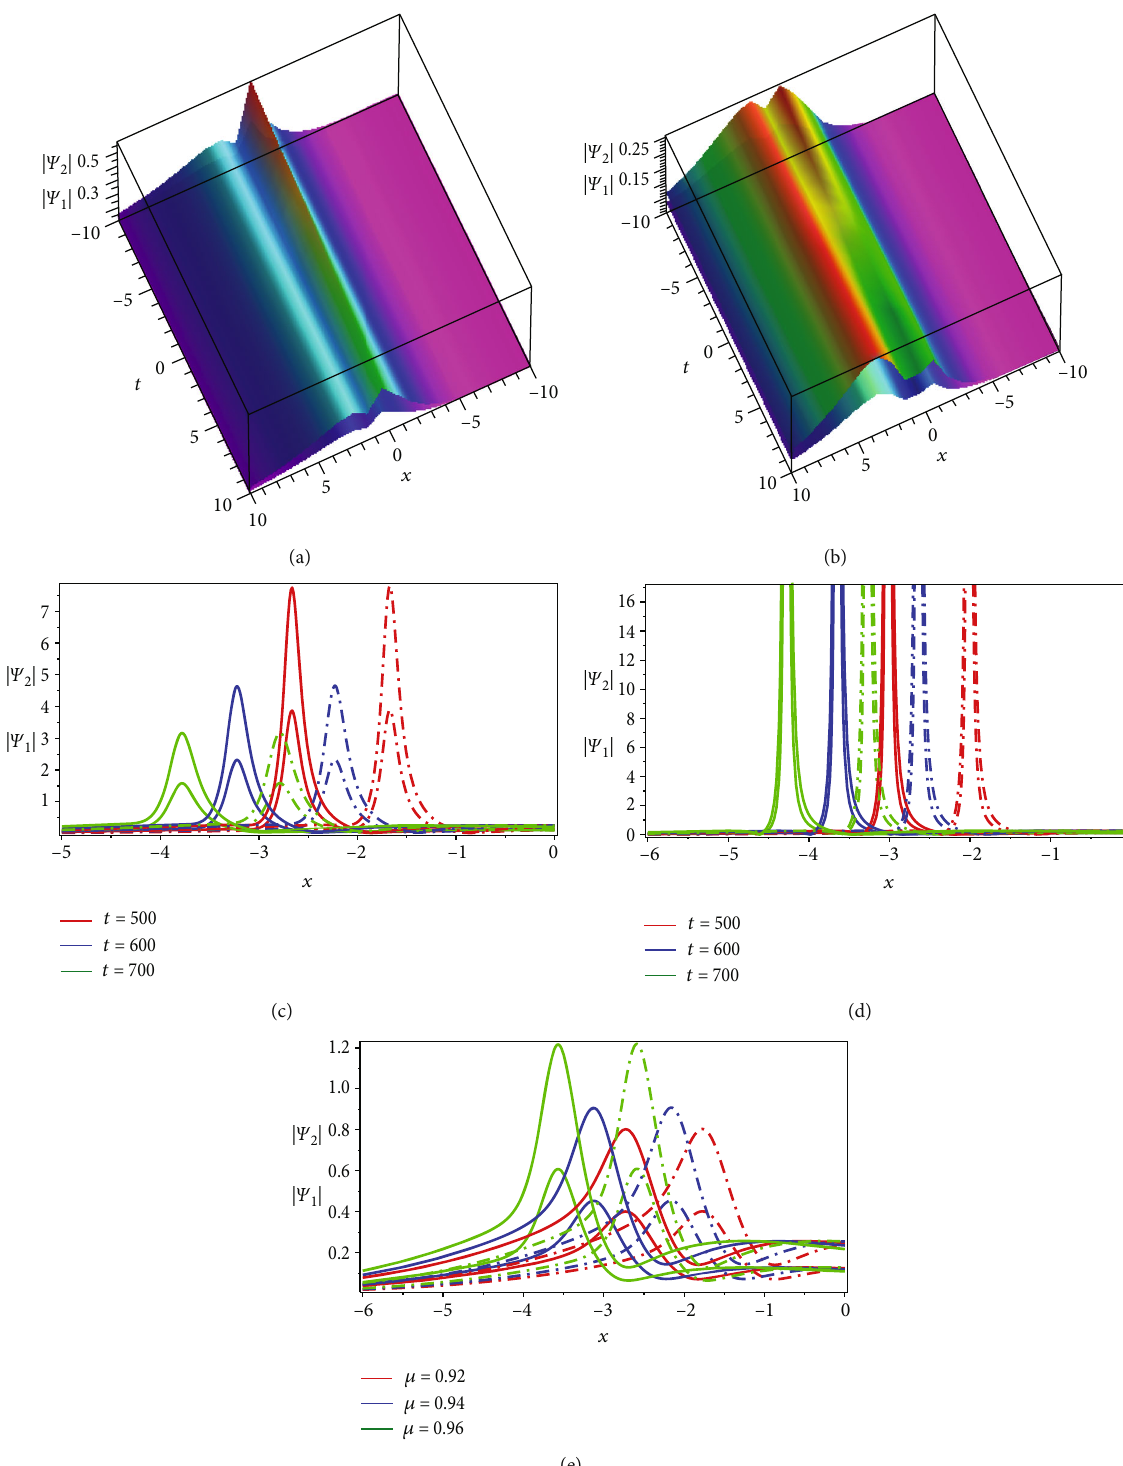
x , t Þj and j Ψ x , t Þj as in Equation (38) and Equation (39), respectively, for (a) BFD parameter Figure 3: Optical rouge wave pro fi les of j Ψ 1 ð 2 ð μ = 0 : 85 , (b) CFD parameter μ = 0 : 85 , the e ff ect (solid line =BFD; dash line =CFD) of time for (c) μ = 0 : 98 and (d) μ = 1 , (e) the e ff ect of fractional parameter for t = 750 . The remaining parameters are α = 0 : 1 , λ = 0 : 5 , σ = 0 : 2 , A = e , M = − 0 : 1 , N = 0 : 5 , κ = 0 : 1 , Π = 2 , p 1 = 0 : 2 , r = − 0 : 2 , s = 0 : 3 , and θ = 1 1 1 0